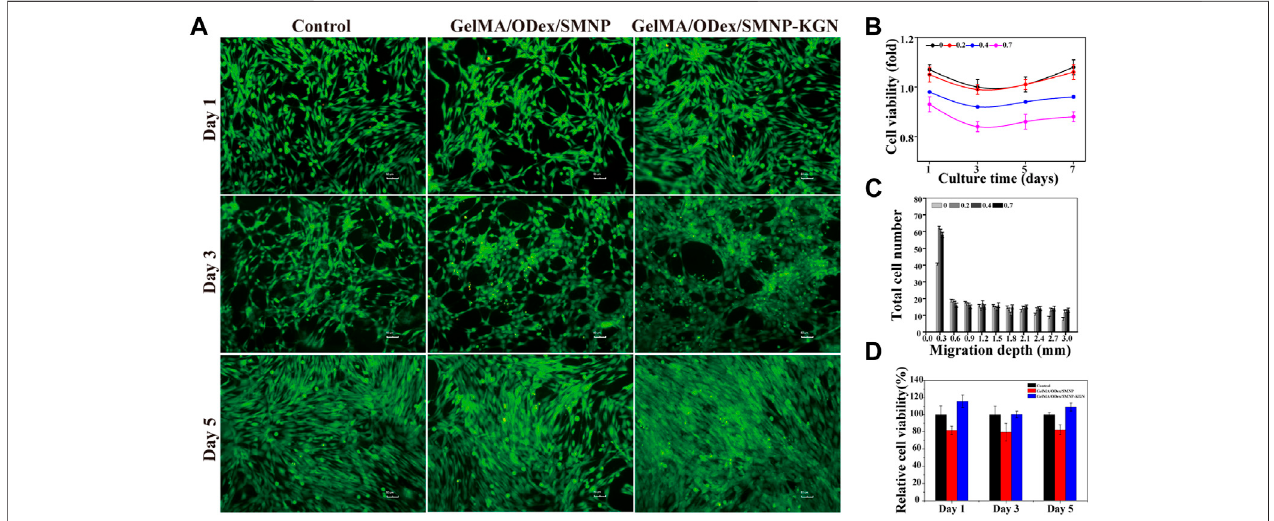
Frontiers in Bioengineering and Biotechnology |